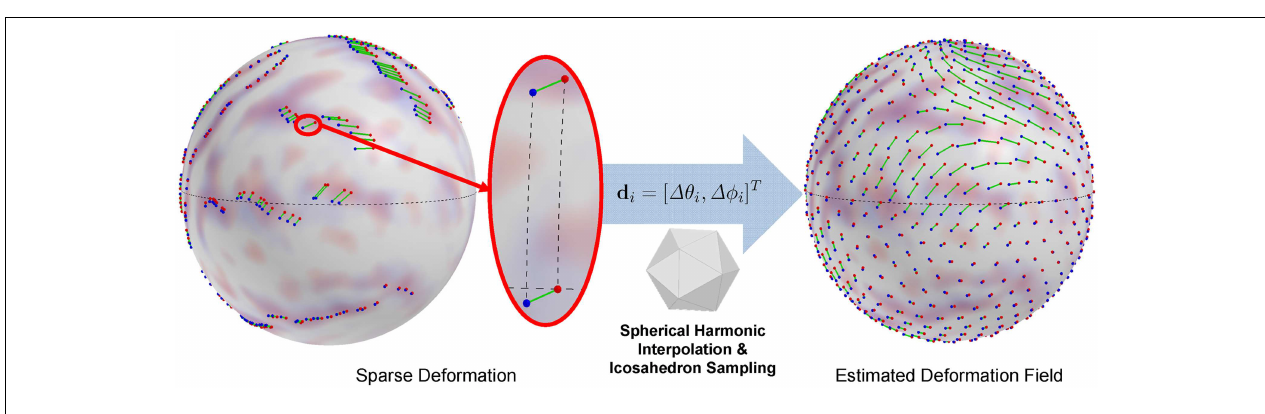
the equator for arclength preservation, which avoids distorted displacement representation. The interpolation of the deformation field is obtained by spherical harmonic